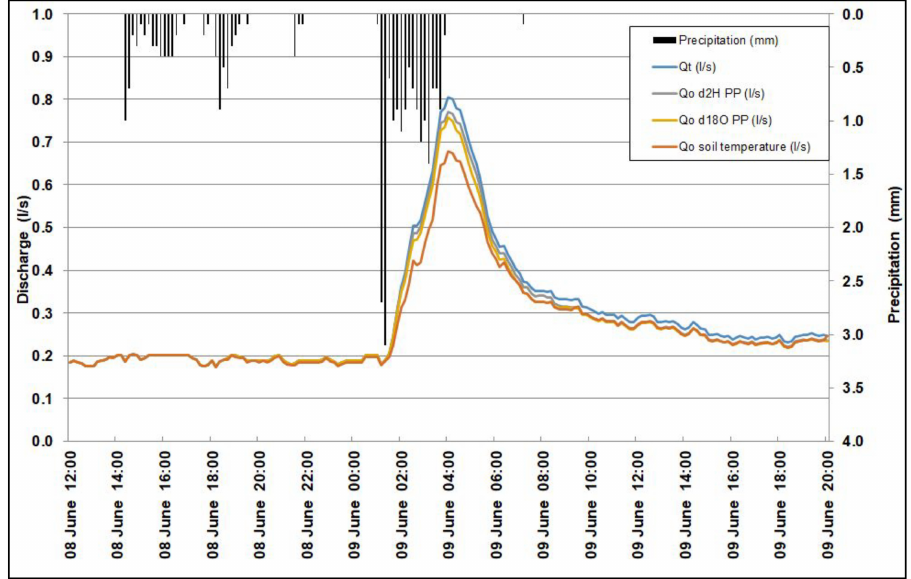
Figure 4. The course of runoff separation in SST-ME 1 based on isotopes of previous precipitation and soil temperature in RRE 1-KL (8 June 2011). Qt, total discharge; Qo d2H PP, discharge of the old water by separations using δ 2 H values of previous precipitation; Qo d18O, discharge of the old water by separations using δ 18 O of previous precipitation; Qo soil temperature, discharge of the old water by separations using soil